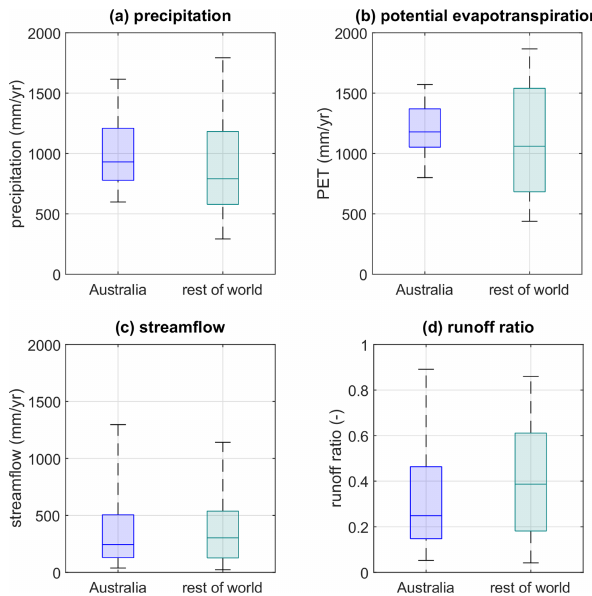
Figure 2. Mean annual values of hydrological variables for the global set of 699 catchments presented by Peel et al. (2010; n Australia = 123, n rest of world = 576). Boxplots show the 5th, 25th, 50th, 75th and 95th percentiles. Potential evapotranspiration in this dataset is a reference crop estimate using a method similar to Harg- reaves’ method, as outlined in Adam et al.